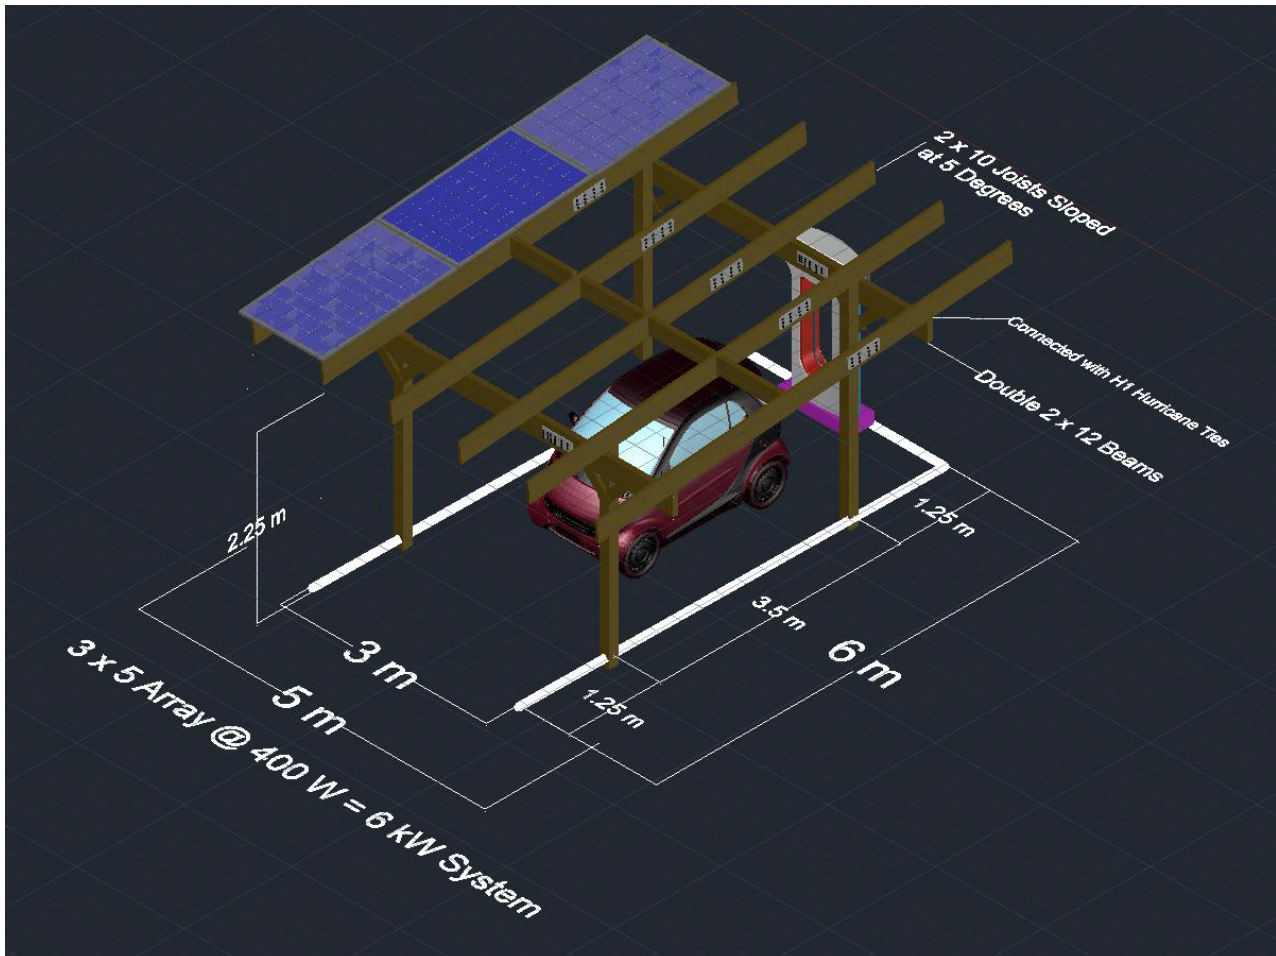
Figure 18. Single-car system for home DIY designs.